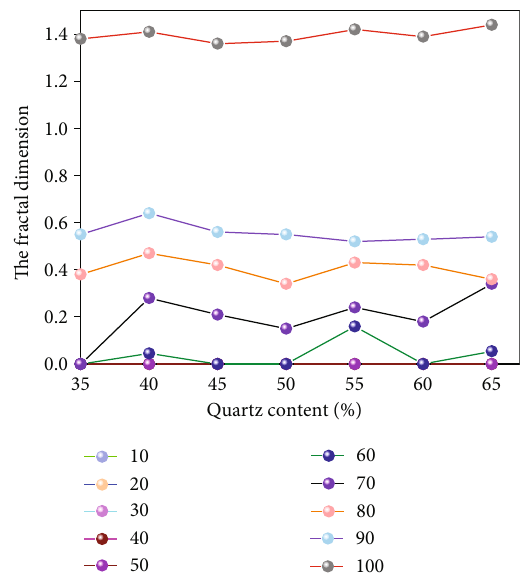
Figure 19: Relationship between the quartz content and fractal dimension at di ff erent stress levels.